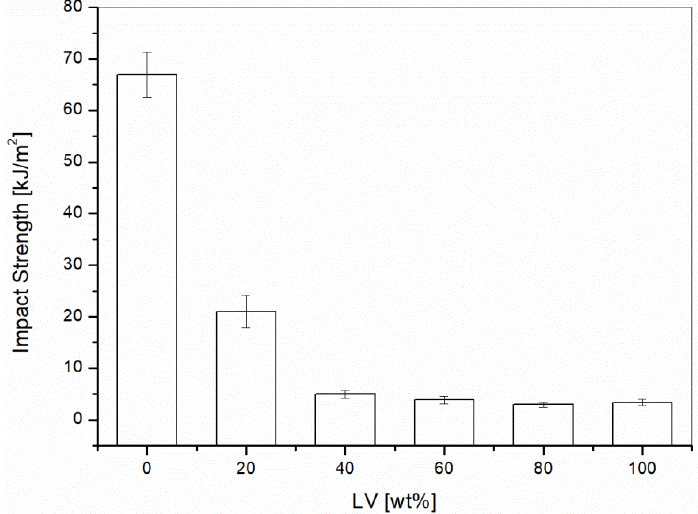
Figure 2. Impact testing on PP/Liquid Wood as a function of the Liquid Wood (LV) content.